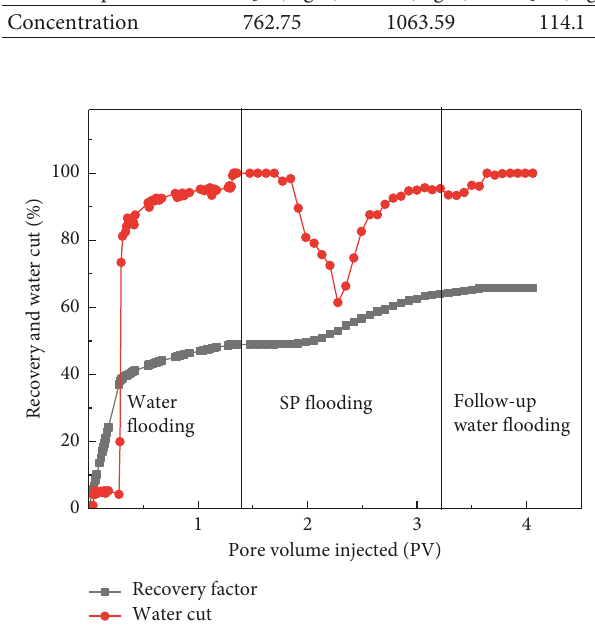
Figure 2: Recovery and water cut of pore